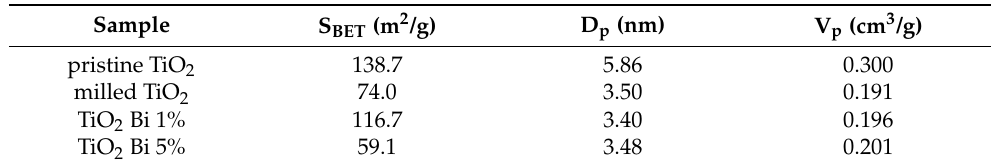
Figure 5. N 2 adsorption–desorption isotherms and pore diameter distribution of the pristine TiO 2 ,